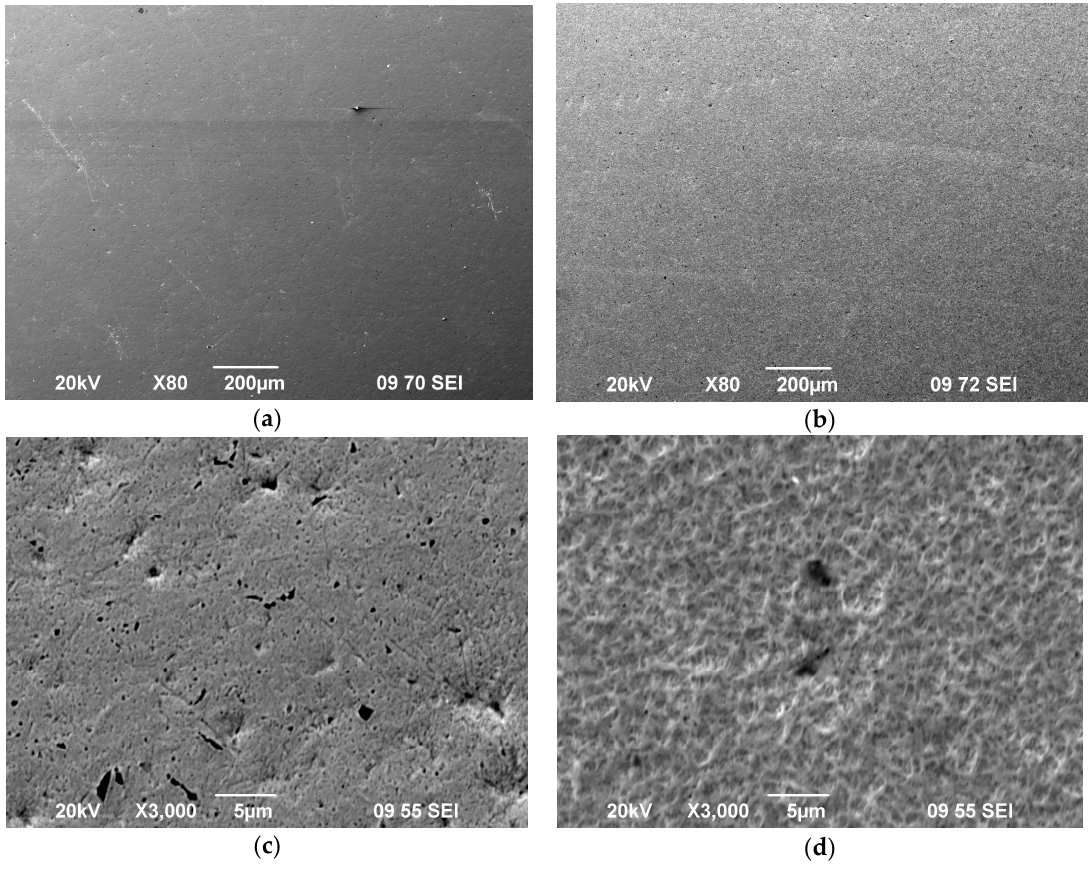
Figure 24. Images of the surface of Sample 6 taken on a Jeol JCM-5700 electron microscope before ( a , c ) and after irradiation to a fluence of 6.7 × 10 20 cm − 2 ( b , d ). Table 2. Temperature of samples of tantalum foil welded to copper.